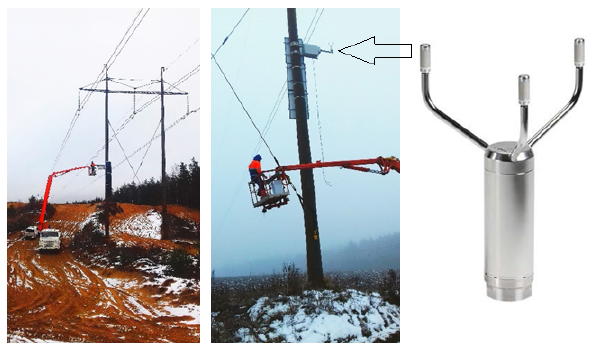
Figure 2. Installation of sonic anemometers in power line poles and Vaisala WMT 700 sensor head